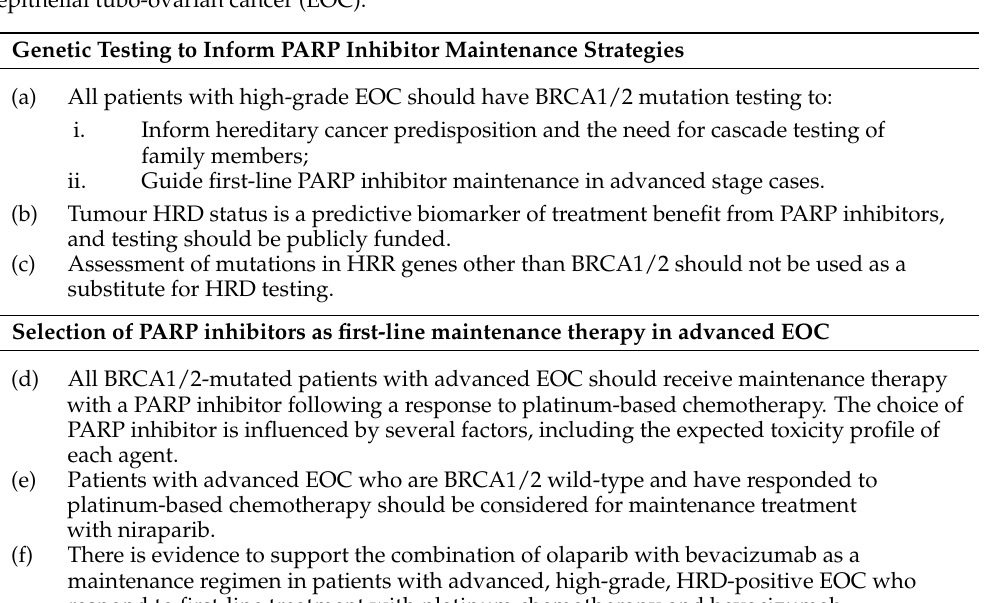
Table 1. Summary of consensus statements for the selection and use of Poly(ADP-ribose) polymerase (PARP) inhibitor maintenance therapy after first-line therapy in patients with advanced, high-grade epithelial tubo-ovarian cancer